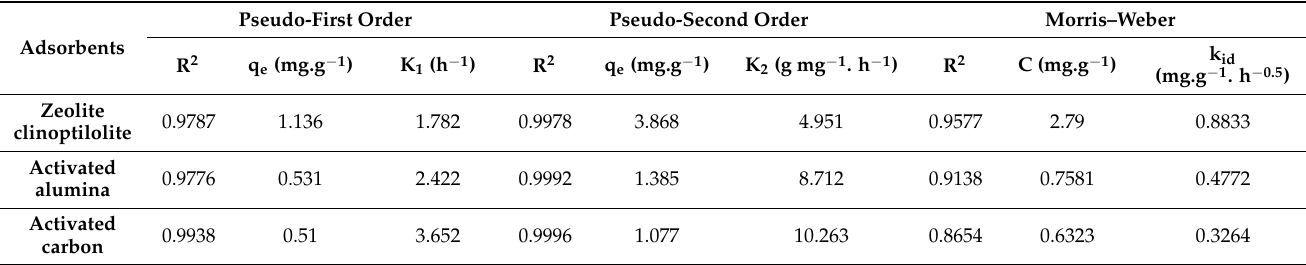
Table 5. Correlation coefficients and constant values of the kinetic models for the adsorption of calcium ions by different